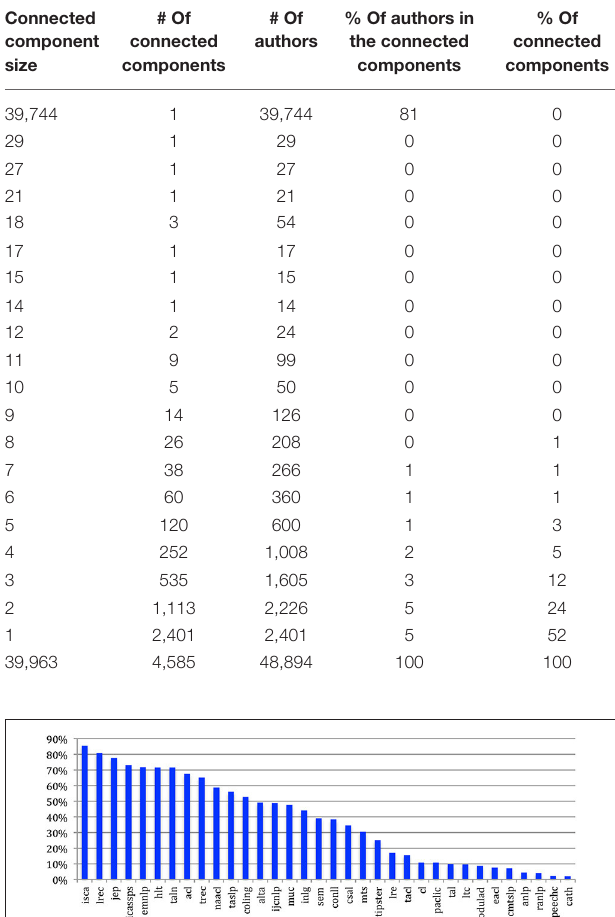
TABLE 7 | Connected components in the collaboration graph.